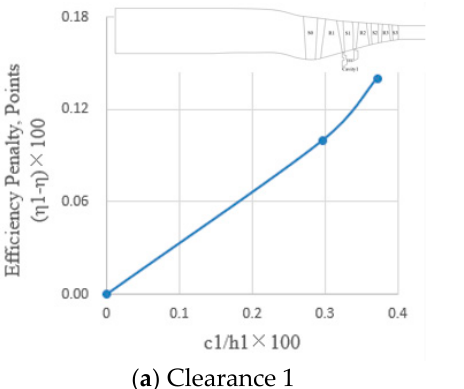
Figure 10. Streamlines at near-stall point for 3 different configurations.